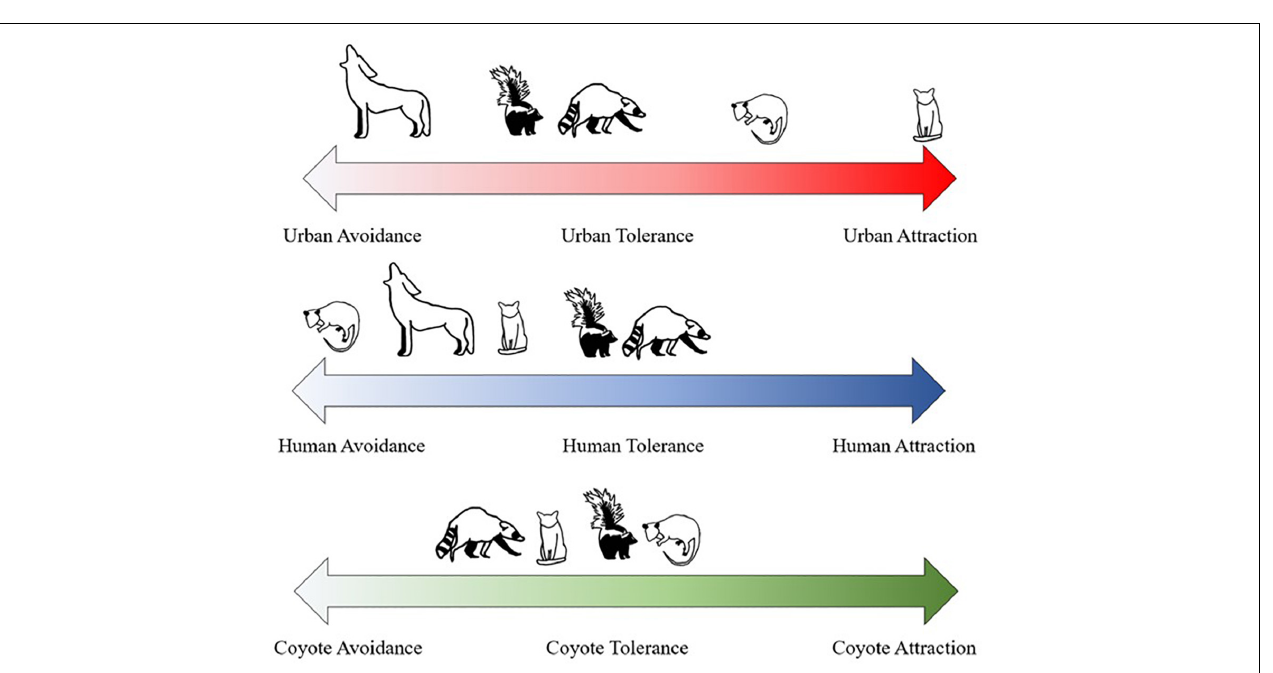
FIGURE 6 | Mammalian mesopredator (coyote, raccoon, opossum, striped skunk, and domestic cat) responses to urban areas, humans, and coyotes. Species fall along a spectrum of either avoidance, or attraction for each stressor, with area in the middle representing a general